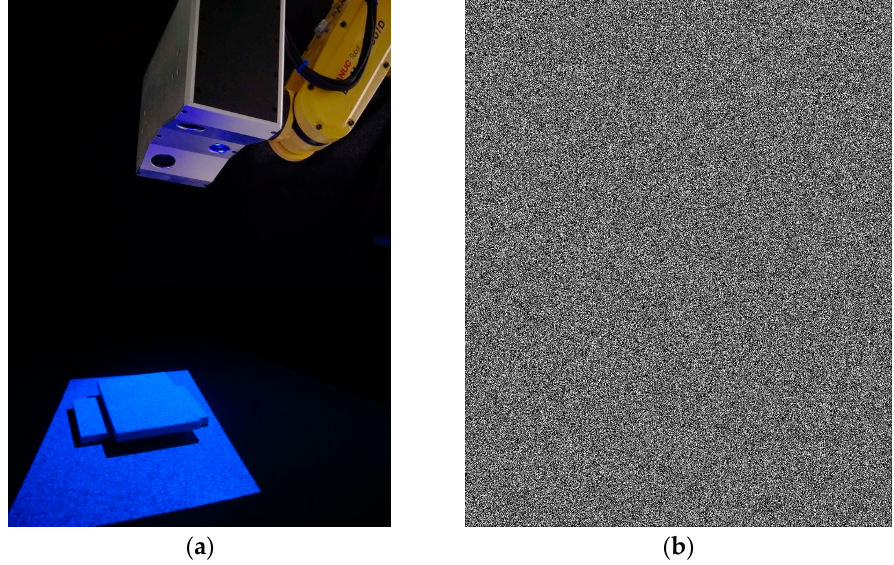
Figure 6. Experimental system. ( a ) Single-shot stereo system with speckle projection; and ( b ) randomly-generated speckle pattern.